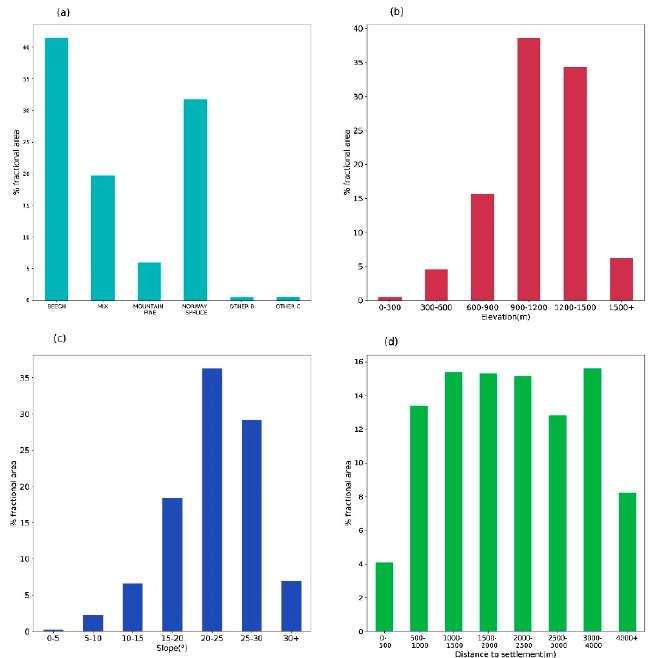
Figure 2. Proportional area of old-growth forest by ( a ) tree species, ( b ) elevation, ( c ) slope and ( d ) distance to settlement. Abbreviations as in Figure 1.